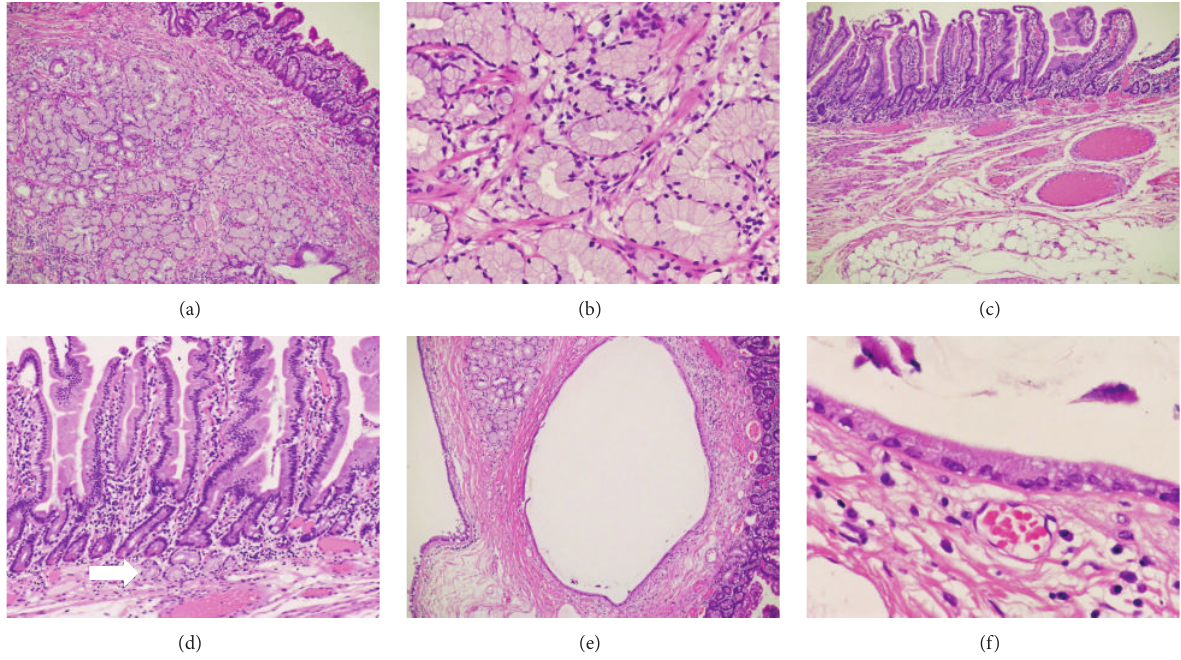
Figure 5: Pathological images. Stromal cell proliferation and lobular arrangement of proliferated Brunner’s glands separated by fibromuscular septaarevisibleintheheadofthepolyp((a), × 4;(b), × 20).Inthestalk,multiplebloodvesselsandadiposetissuescanbeseen((c), × 4;(d), × 10). Brunner’s glands are only partly visible in the stalk ((d), arrow). The cystic structure visible in the head of the polyp is lined with columnar cells ((e), × 4; (f), × 40). Based on the pathological features, a diagnosis of Brunner’s gland hamartoma was